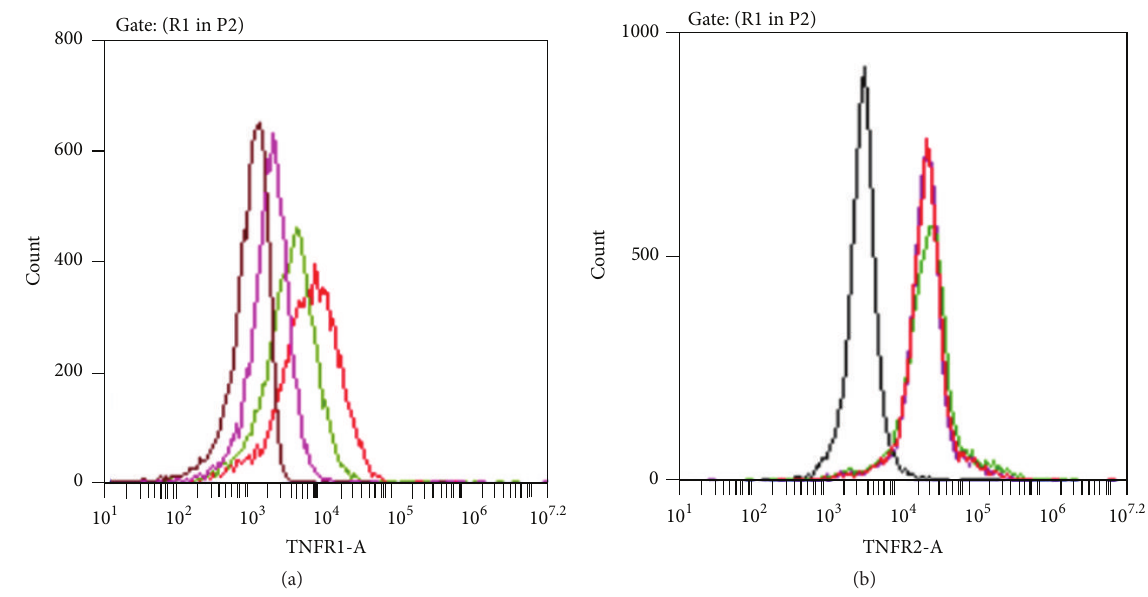
Figure 5: An example of flow cytometry overlay histograms. Overlay histograms are shown for gated monocytes from one subject. (a) Four histograms are shown, with fluorescence intensity in the PE channel on the 𝑥 -axis and cell count on the 𝑦 -axis. The black histogram represents LPS-stimulated monocytes incubated with a PE-labelled isotype control antibody. The red histogram represents monocytes stimulated with LPS and labelled with PE-TNFR1 mAb. Green and pink histograms represent LPS-stimulated monocytes incubated in the presence of TNF- 𝛼 mAborTNFR2mAb,respectively,andthenlabelledwithPE-TNFR1mAb.ThealteredpositionsofthehistogramsillustratetheeffectofTNF- 𝛼 or TNFR2 blockade on subsequent TNFR1 expression. (b) Four histograms are shown, with fluorescence intensity in the FITC channel on the 𝑥 -axis and cell count on the 𝑦 -axis. The black histogram represents LPS-stimulated monocytes incubated with a FITC-labelled isotype control antibody. The red histogram represents monocytes stimulated with LPS and labelled with FITC-TNFR2 mAb. Green and pink histograms represent LPS-stimulated monocytes incubated in the presence of TNF- 𝛼 mAb or TNFR1 mAb, respectively, and then labelled with FITC- TNFR2 mAb. Red, green, and pink histograms overlay each other exactly illustrating that in this subject’s monocytes there was no effect of TNF- 𝛼 or TNFR1 blockade on subsequent TNFR2 expression. Each of the three experimental conditions was conducted alongside samples subjected to the same conditions but incubated with an isotype control flow cytometry antibody. As all isotype control histograms overlaid each other, only one of three is shown in each graph for ease of